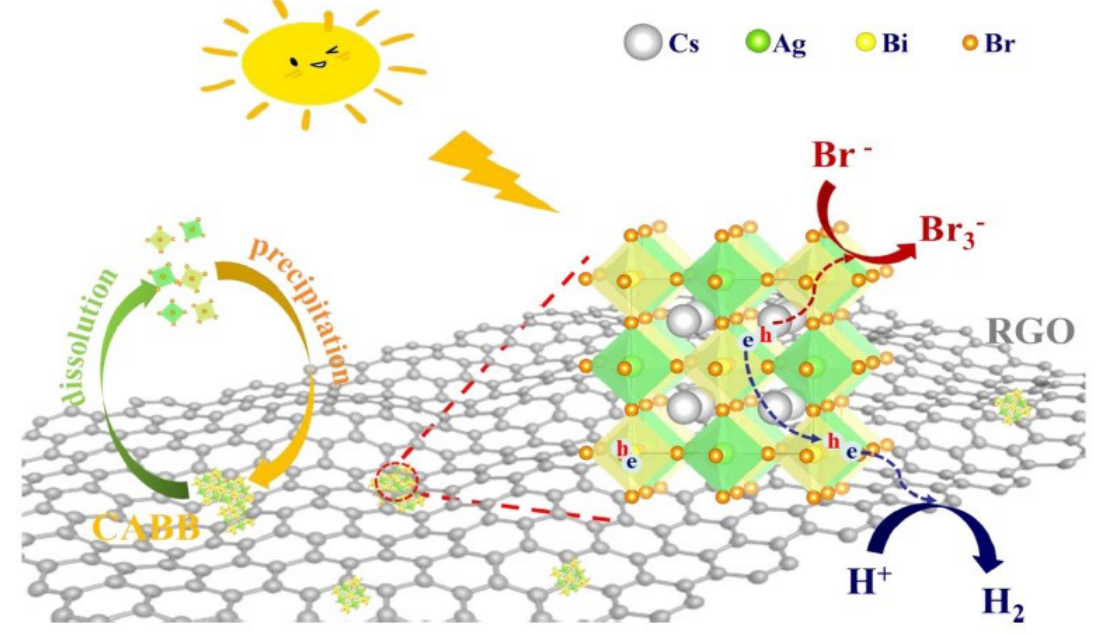
Figure 9. Schematic mechanism of H 2 evolution by CABB/RGO under visible light irradiation. Reprinted with permission from ref [38]: Copyright 2019, Elvisier B.V.